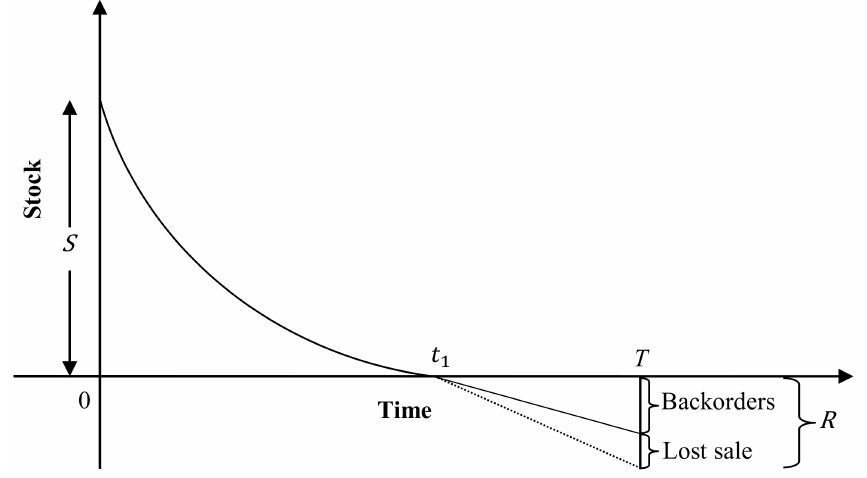
Figure 1. Graphical representation of the proposed inventory model for Case